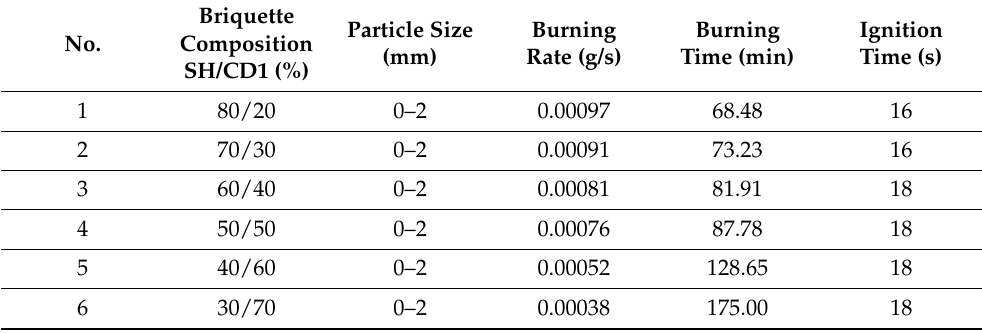
Table 11. The result of burning rate, burning time, and ignition (leaves and Shubarkul coal